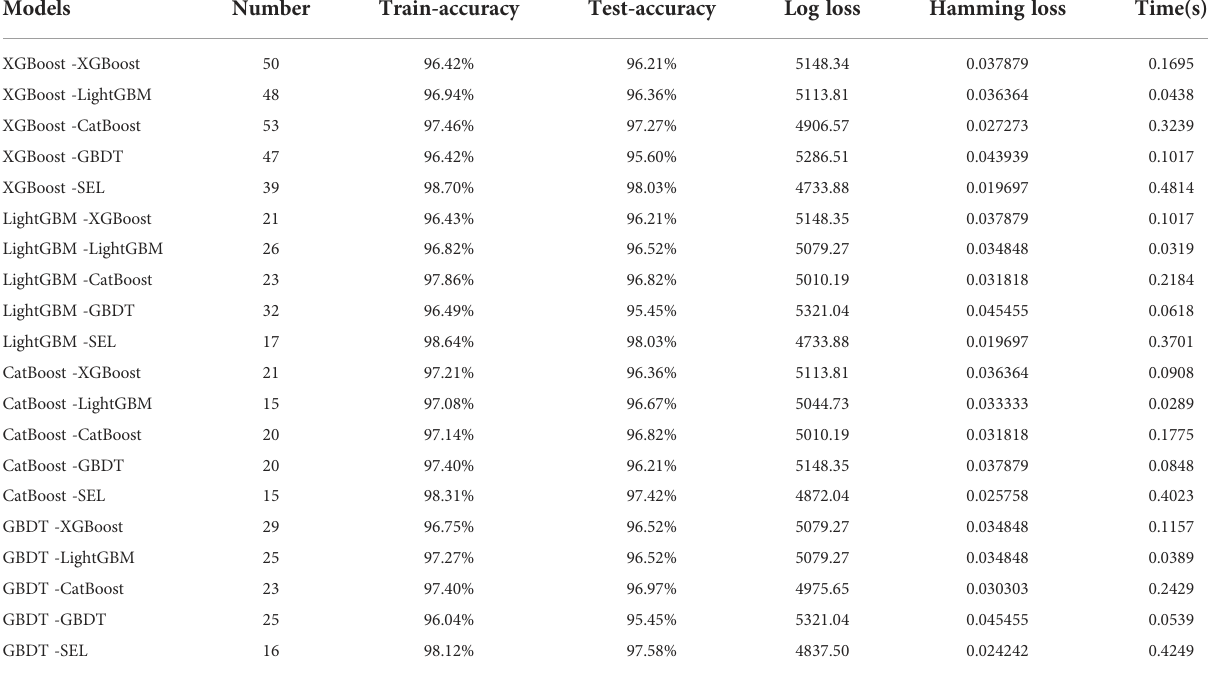
TABLE 1 Evaluation indicators for the classi fi cation results of peanut seed samples using four variable selection methods combined with fi ve classi fi cation models. Models Number